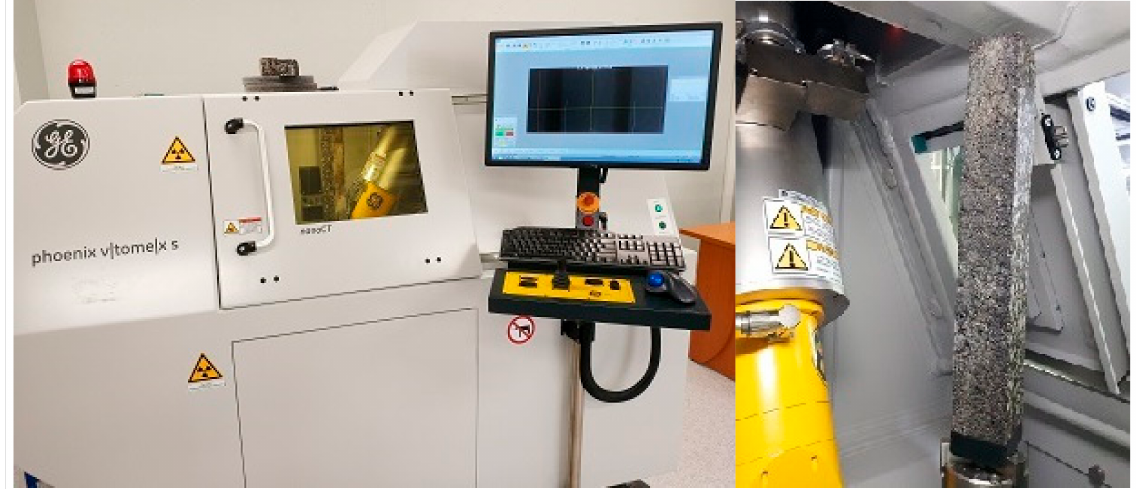
Figure 15. Computed tomography and mounted specimen.